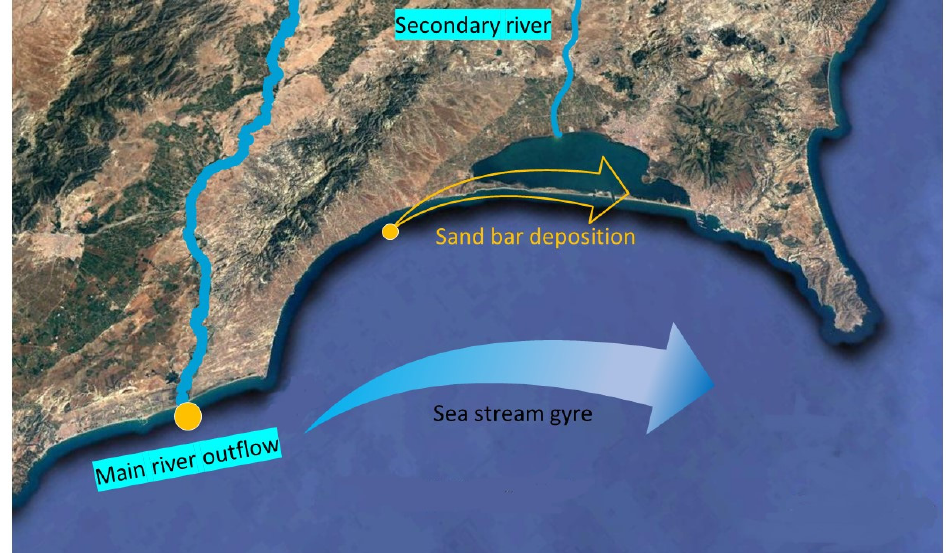
Figure 1. Ideal coastal lagoon formation scheme. Base figure: Google Earth.